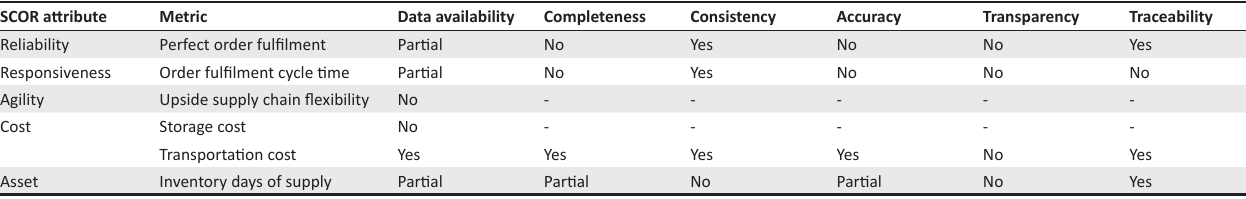
TABLE 1: Summary of the data quality for Iteration 1. SCOR